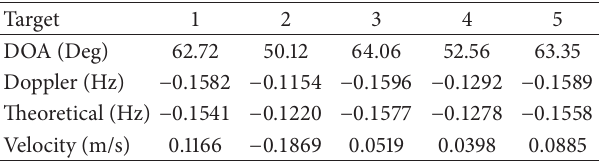
Figure 8: Space-time spectrum of real data adds simulation target. Table 1: DOA and Doppler estimations.